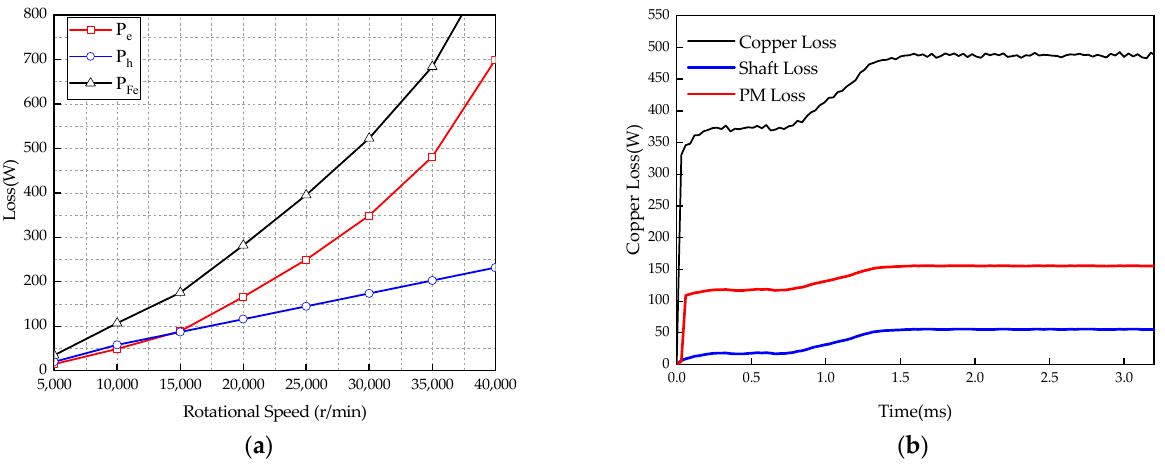
Figure 24. Loss curves of High ‐ speed PM motor: ( a ) Iron loss with different rotational speed; ( b ) Transient diagram of stator copper loss and PM loss.